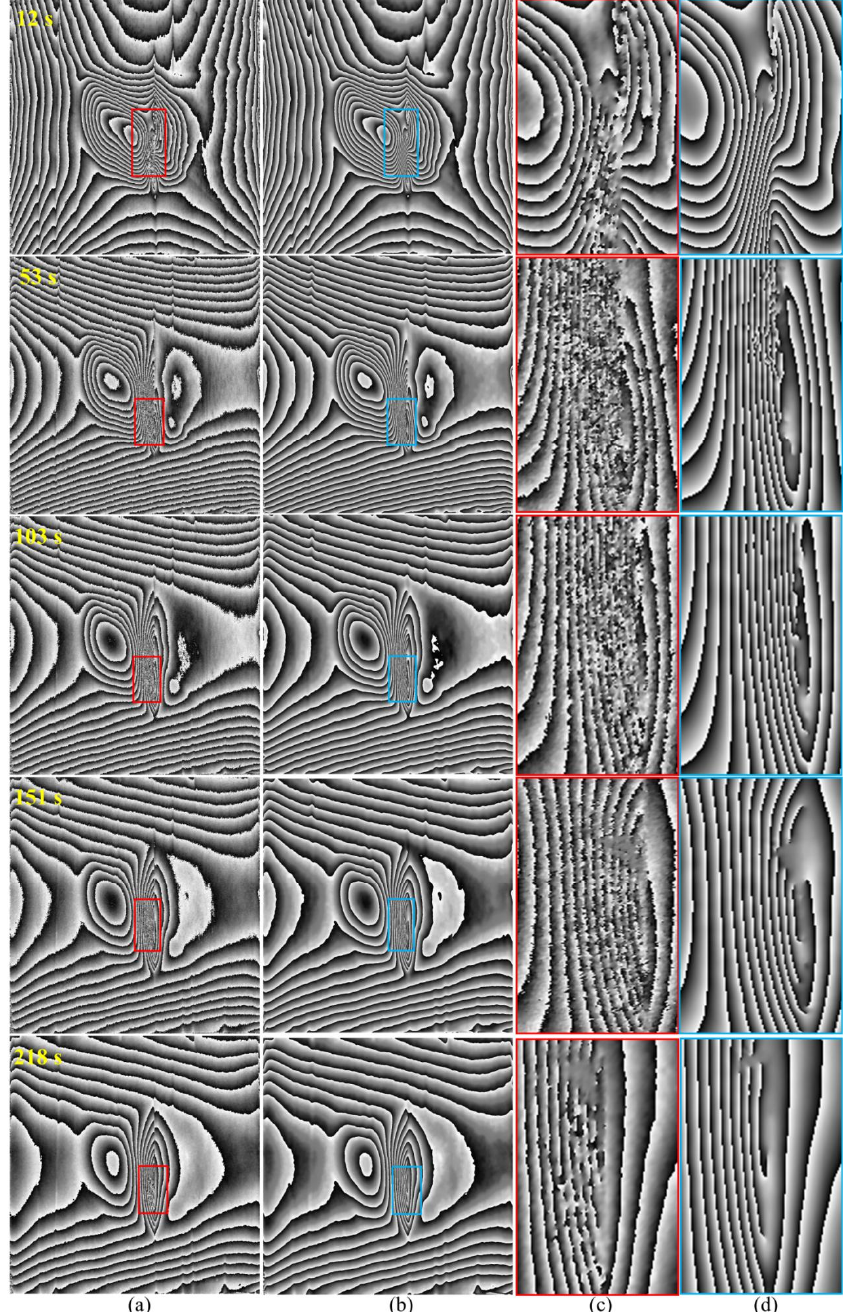
Figure 9. Experiment results: ( a ) Denoising result by DHSPI system; ( b ) denoising result by the proposed method; ( c ) enlarged region of (a); ( d ) enlarged region of (b).